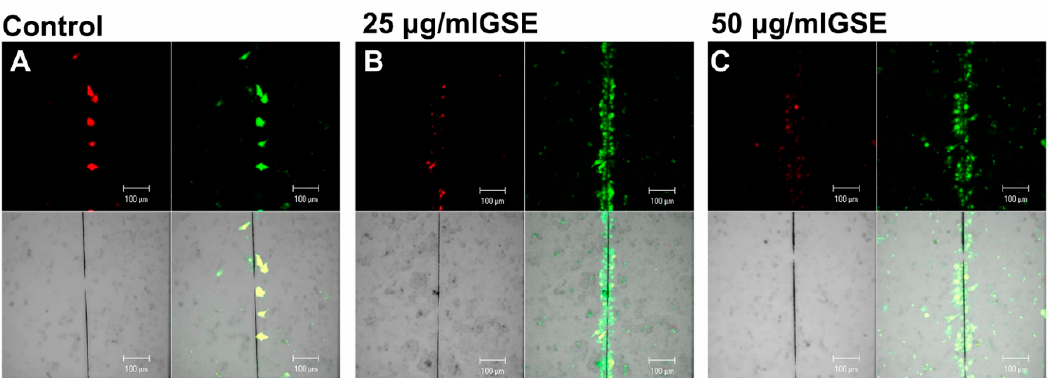
Figure 4. Gap-junction-mediated cell-cell communications (GJIC) functionality assessed by scrape-loading / dye-transfer (SL / DT) assay in MCF-7 cells treated with GSE (25 or 50 µ g GAE / mL) for 30 min. Each image is representative of three independent experiments, each done in triplicate ( n = 27) and shows the single channel detection of the cells containing the non-gap junctions (GJs) -permeant Rhodamine dextran, 10,000 MW (red), or the GJ-permeable Lucifer Yellow CH (green) or transmitted light images (in grey); at the bottom right of each image is the match of all channels. ( A ) Non-treated cells (controls); ( B ) cells treated with 25 µ g / mL GSE; ( C ) cells treated with 50 µ g / mL GSE. Bars 100 µ m.